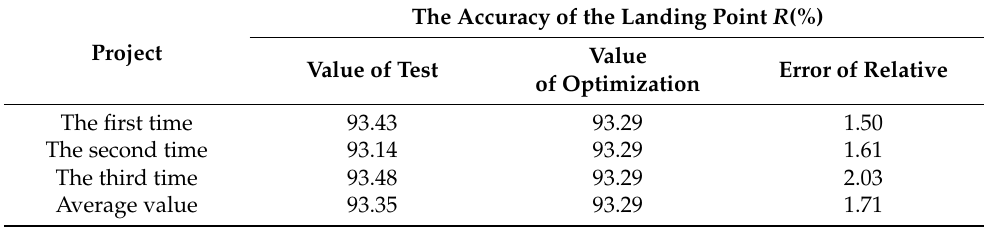
Table 4. Model optimization and experimental